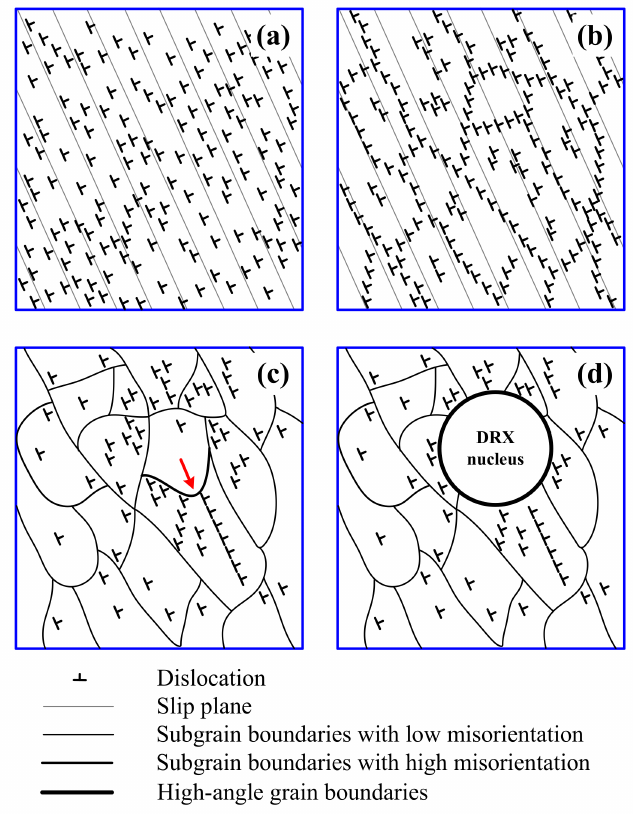
Figure 12. Schematic diagram showing the nucleation model of DRX randomly occurred in the original grain interiors by uniform increase in misorientation between subgrains. (Note that only dislocations of one sign are shown in the schematic diagram for simplifying model.) ( a ) Dislocation generation, ( b ) subgrain formation, ( c ) subgrain boundary migration and ( d ) DRX grain